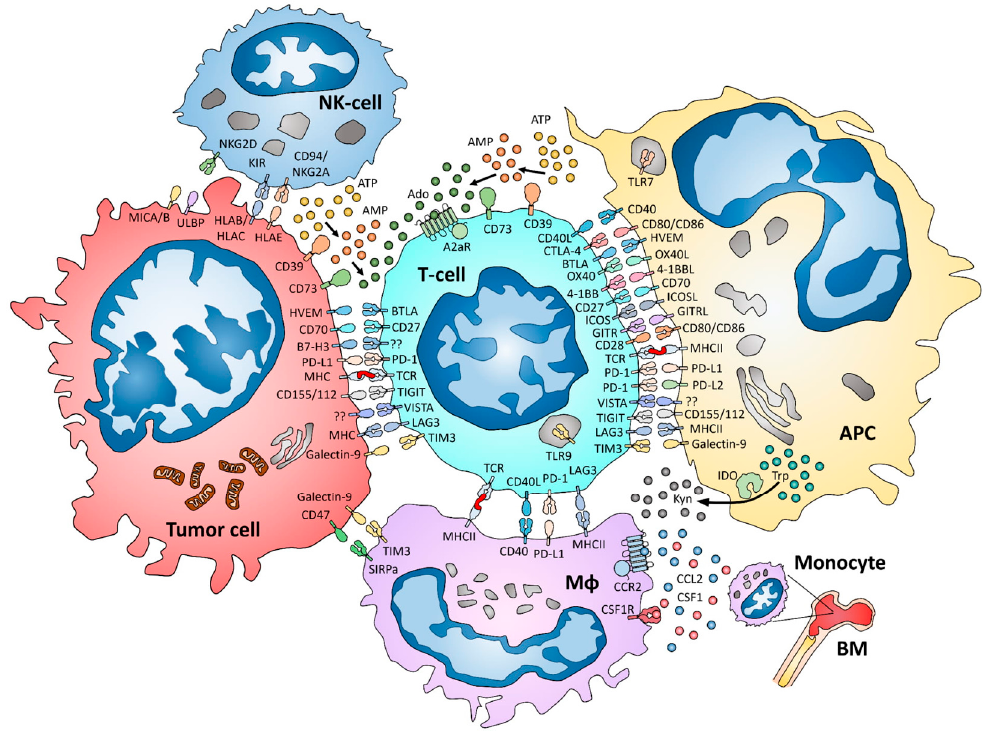
Figure 1. Interplay between tumor cells and immune system components in the tumor microenvironment. Abbreviations for represented cells and immune-related markers are explained in the main text.